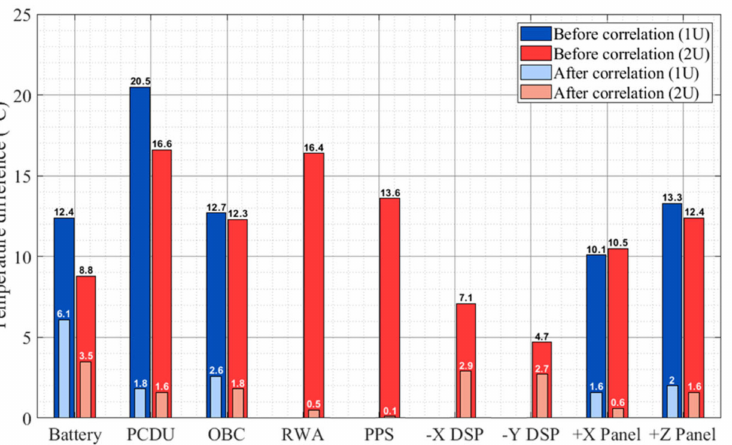
Figure 23. Temperature difference between the TVCT and the numerical analysis before and after the